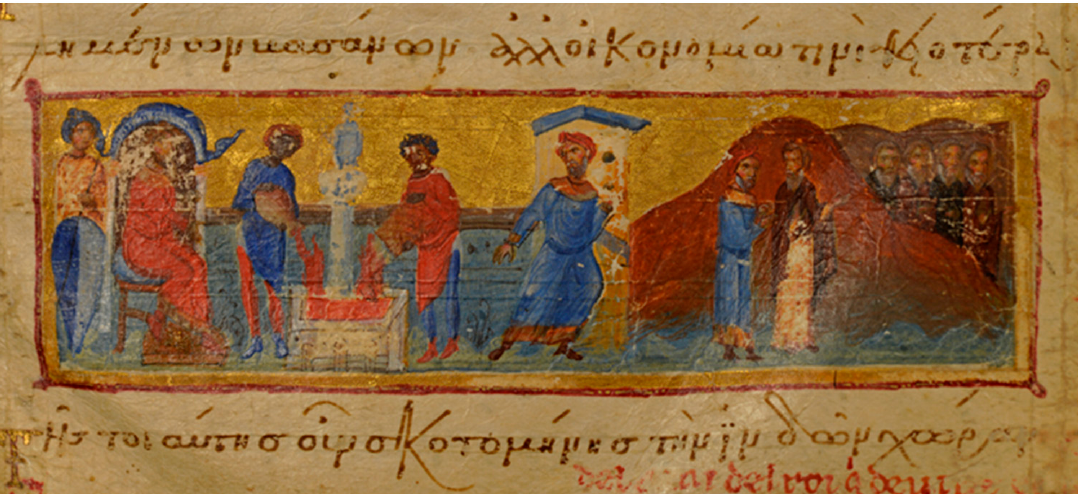
Figure 7. Mount Athos. Holy Iviron Monastery. Athon. Iviron 463, fol. 6r (detail). King Abenner offers sacrifices to an idol. Photo: @Holy Iviron Monastery, Mount Athos, all rights reserved.